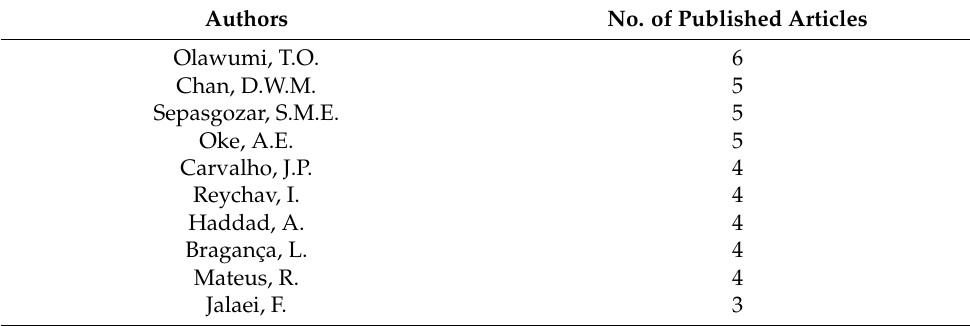
Table 8. Top ten contributing authors and the number of papers they have authored.